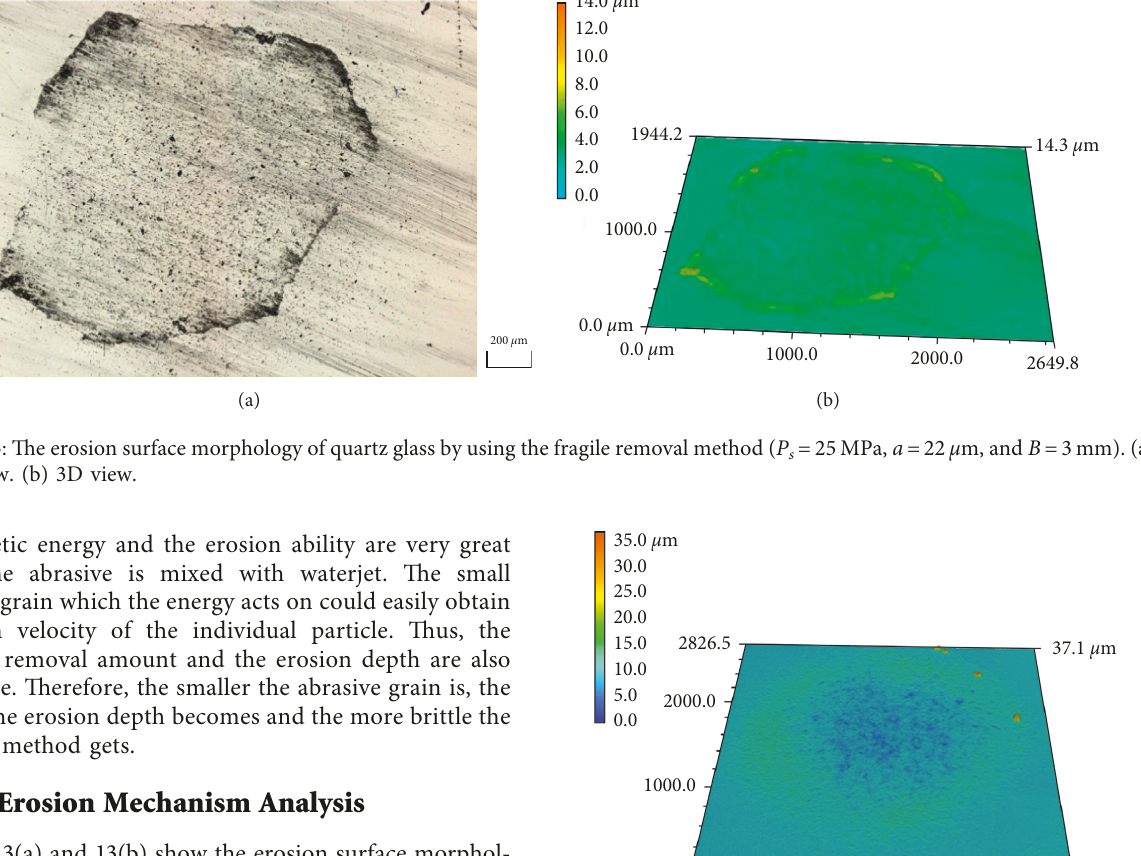
Figure 14: The erosion surface morphology of quartz glass by using the plastic removal method ( P s B (cid:31)